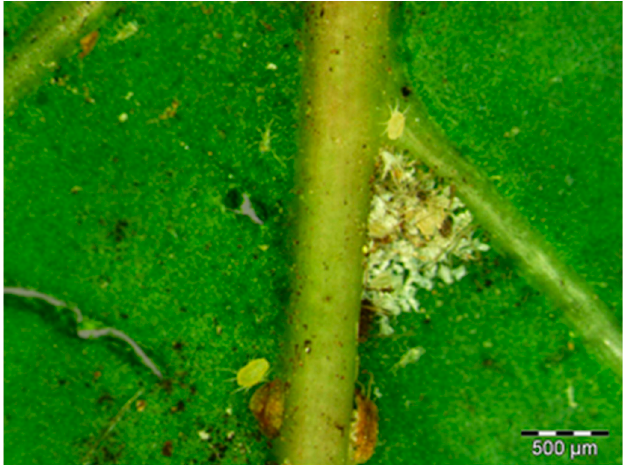
Figure 1. Stereomicrograph showing the location of the leaf domatium of Rothmannia globasa (Hochst.) Keay Rubiaceae in the adaxial side of the leaf.